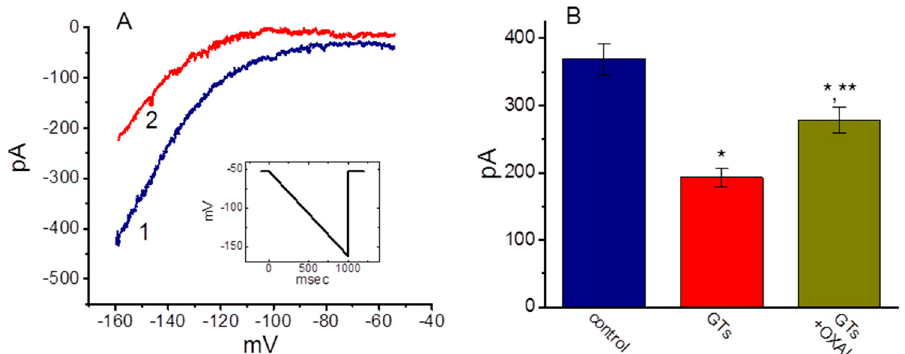
Figure 7. Effect of GTs on I h elicited by a downsloping ramp pulse in HL-1 cardiomyocytes. In these experiments, the examined cell was maintained at − 52 mV and the linear ramp pulse from − 52 to − 162 mV with a duration of 1 sec (as indicated in inset of ( A )). ( A ) Representative I h traces in response to such linear ramp obtained with or without the addition of GTs. Current trace labeled 1 is control, and that labeled 2 was obtained 2 min after addition of 10 µg/mL GTs. (B) Summary bar graph showing effect of GTs and GTs plus oxaliplatin on I h elicited by ramp pulse. Current amplitude was measured at the level of − 152 mV. Each bar indicates the mean ± SEM ( n = 7–8). *Significantly different control ( p < 0.05) and ** significantly different from 10 µg/mL GTs alone group ( p < 0.05).